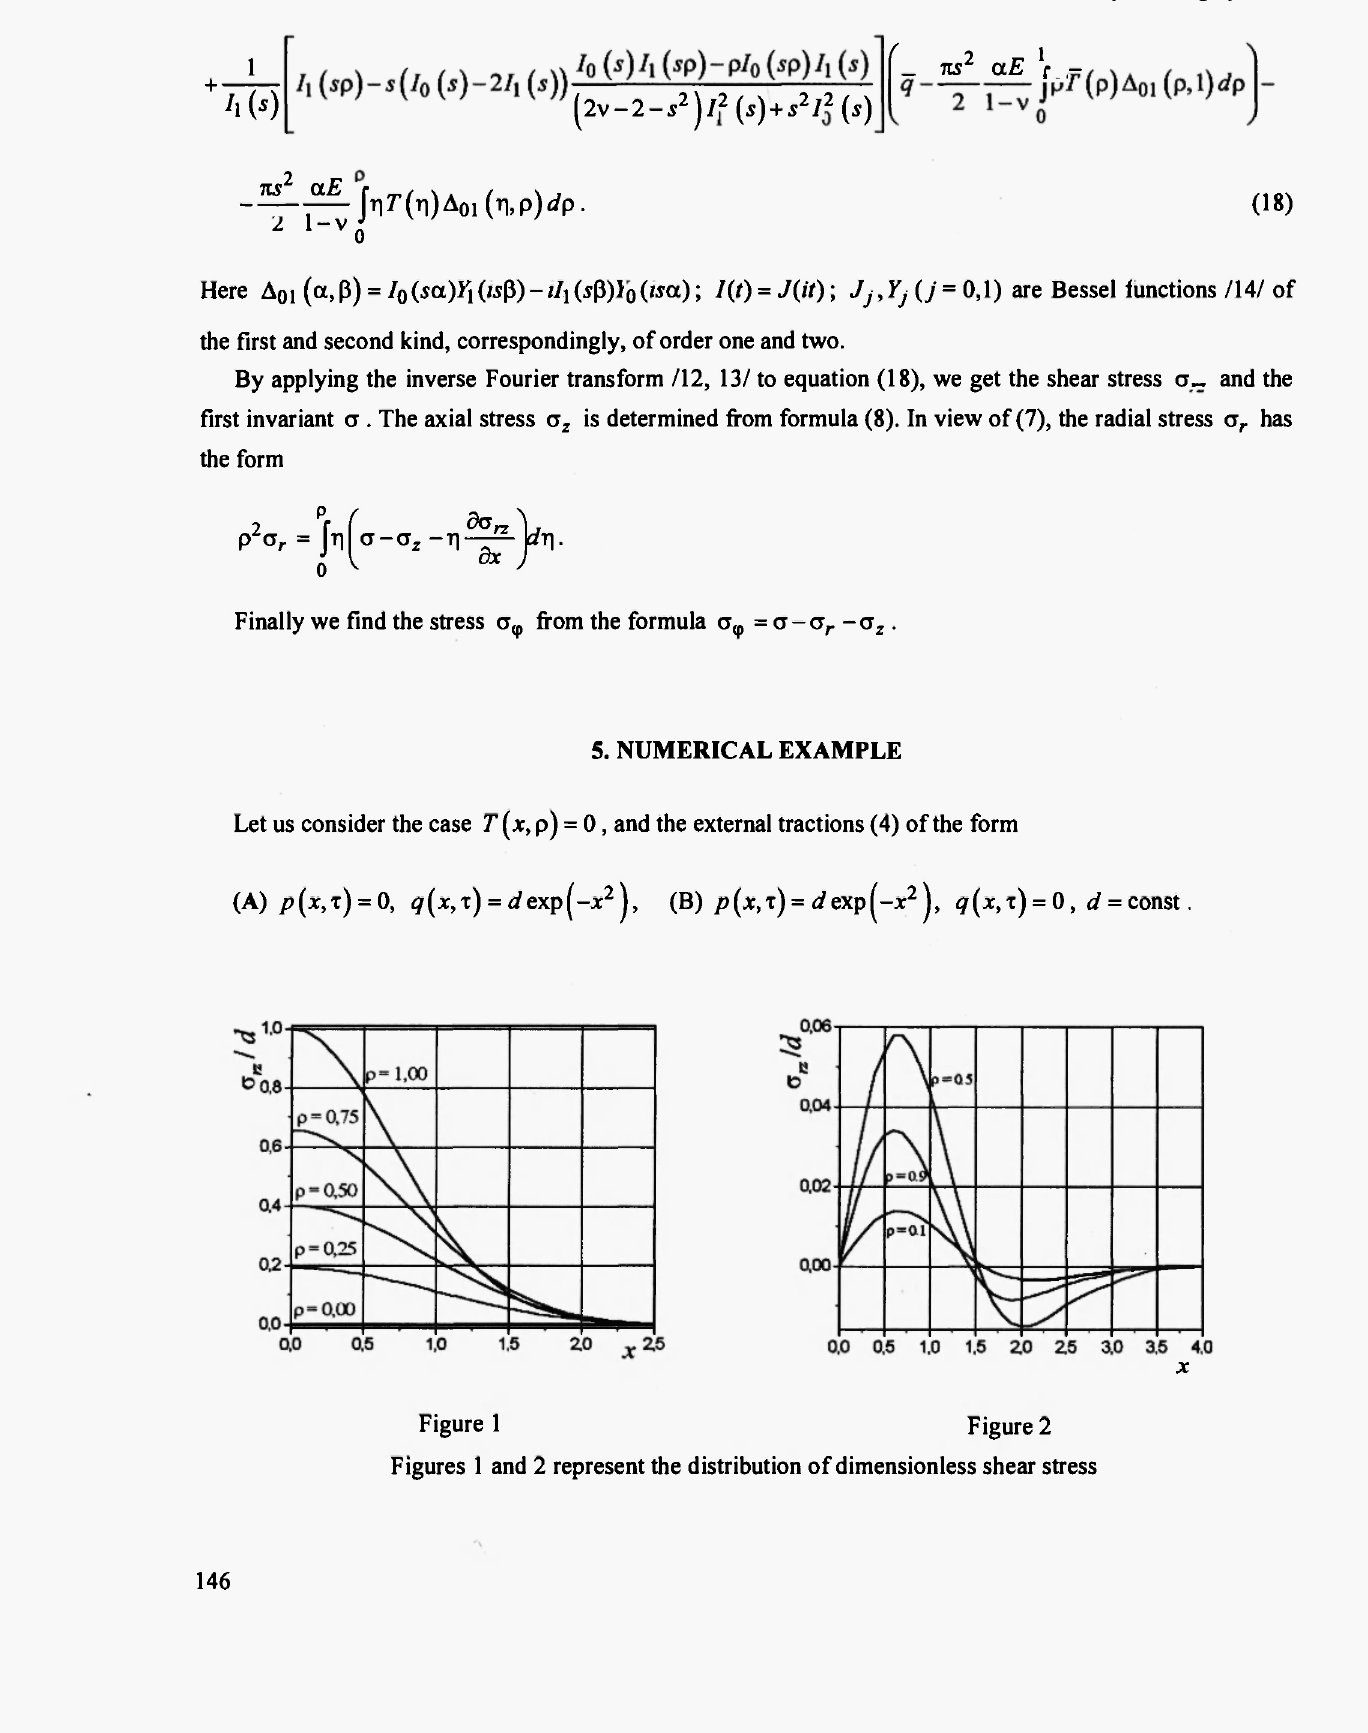
Figures 1 and 2 represent the distribution of dimensionless shear